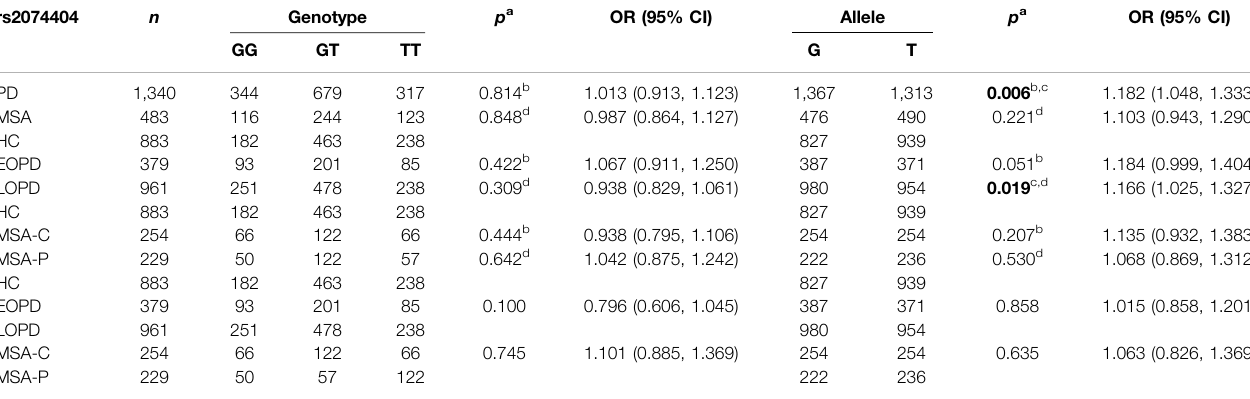
interval. b Comparisons between PD and HC, between EOPD and HC, or between MSA-C and HC. c Signi fi cant ( p < 0.05).